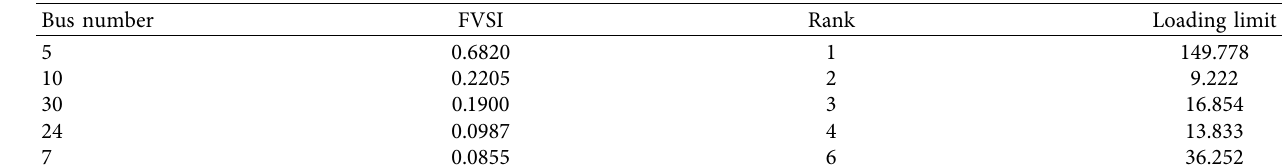
Table 1: Weak buses ranking using